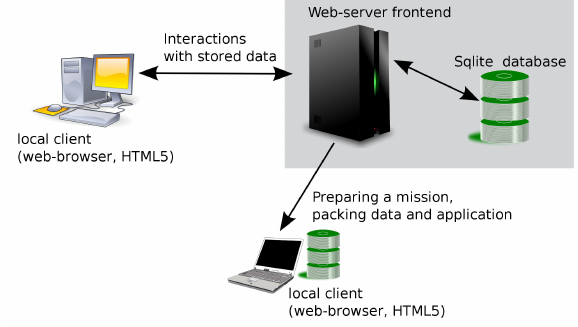
Figure 6: Different steps of the image processing: Raw photograph; clipped image; colored 3d mesh; raw mesh; mesh detail.